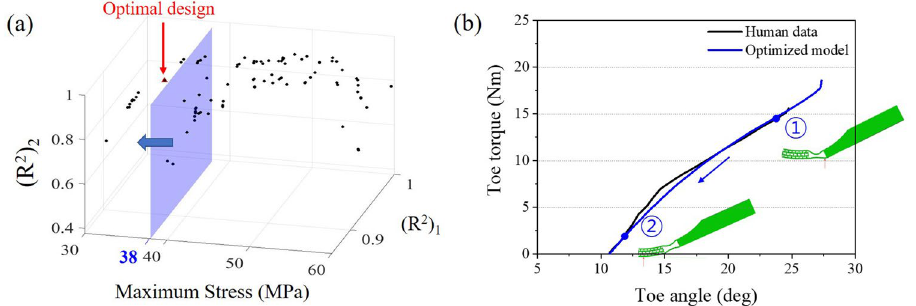
Figure 9. The results of the optimization process; ( a ) Pareto optimal solutions; ( b ) toe torque, angle graph and normal contact force position derived from heel off to toe off